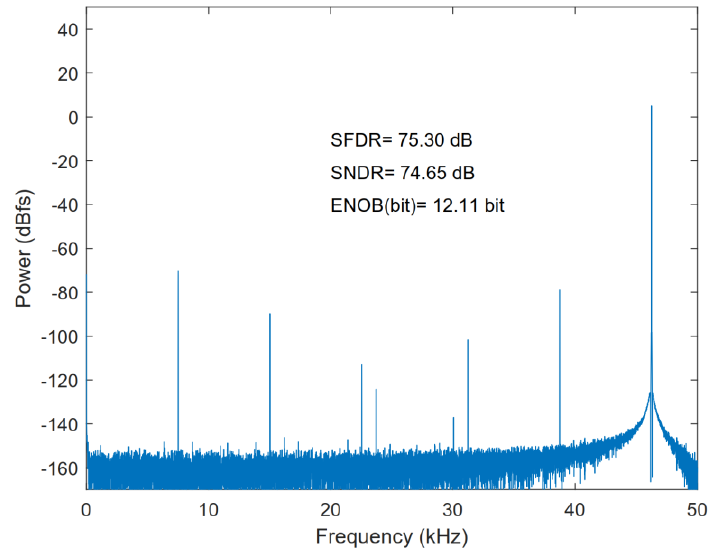
Figure 9. Transient simulation of sampling switch.